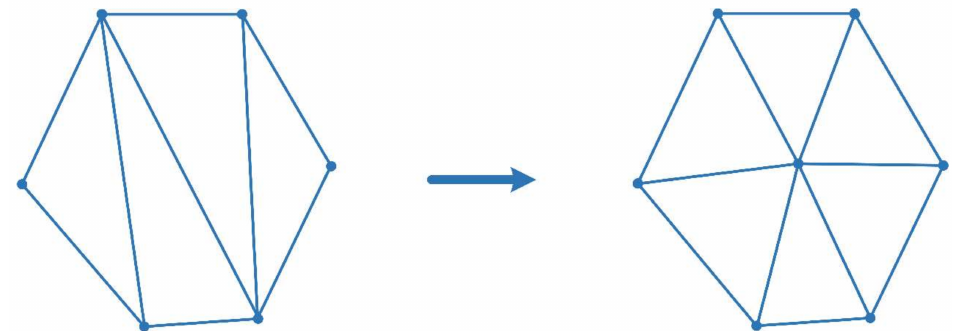
Figure 2. The addition of clustering centers reduces the number of narrow triangles.